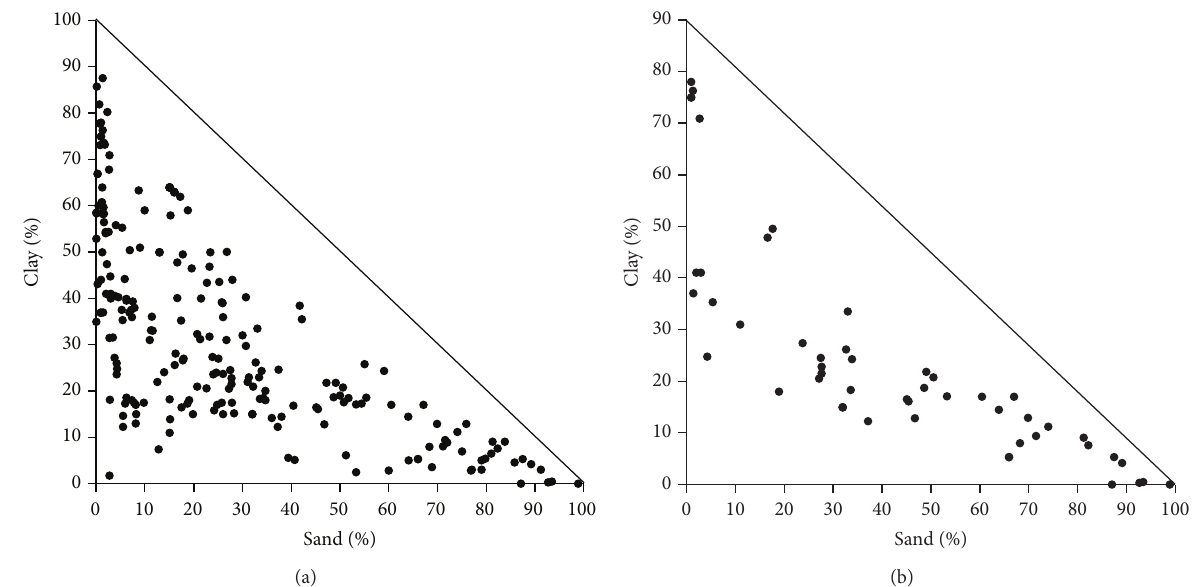
Figure 1: Soil texture of all selected soils (a) and verification dataset (b). Clay ( < 0.002 mm) and silt (0.002–0.05 mm).